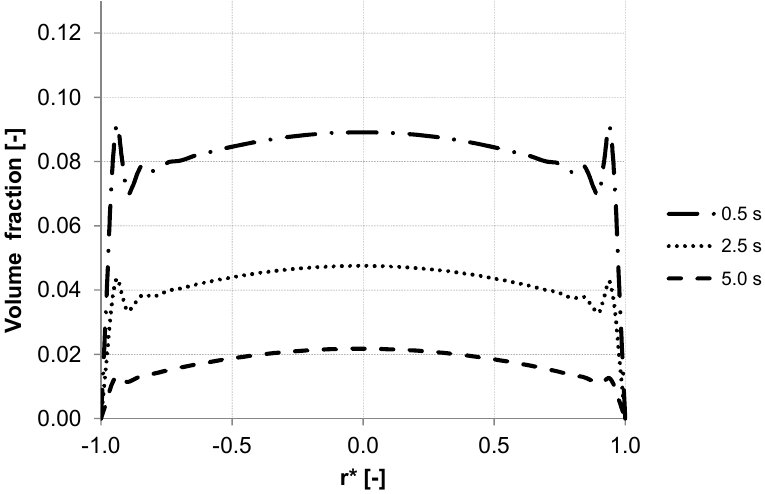
Figure 8. Particle distributions along control line C with not considered lift force and backwashing flux 300 L m − 2 h − 1 during 5 s ( cf. Figure 7).